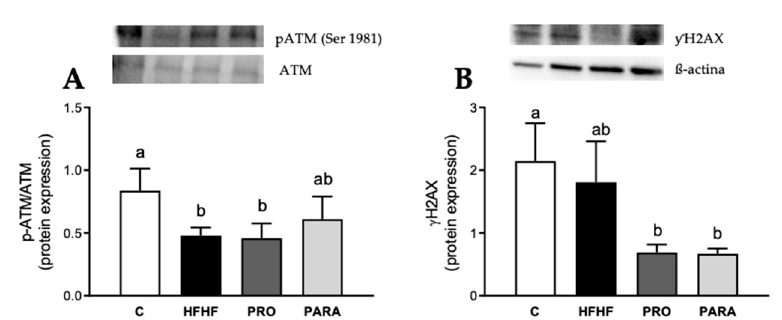
Figure 3. Activation rate (phosphorylation) of ATM ( A ) and protein expression levels of γ H2AX ( B ) in liver samples of rats fed a control diet (C), a high-fat high-fructose diet (HFHF) or a high-fat high- fructose diet supplemented with viable or heat-inactivated 10 9 CFU/day of Lactobacillus rhamnosus GG (PRO and PARA, respectively). Values are presented as mean ± SEM. Differences among the groups were determined by using one-way ANOVA, followed by the Newman–Keuls post hoc test. Bars not sharing common letters are significantly different ( p < 0.05). ATM: ataxia-telangiectasia mutated, γ H2AX: phosphorylated histone H2AX.